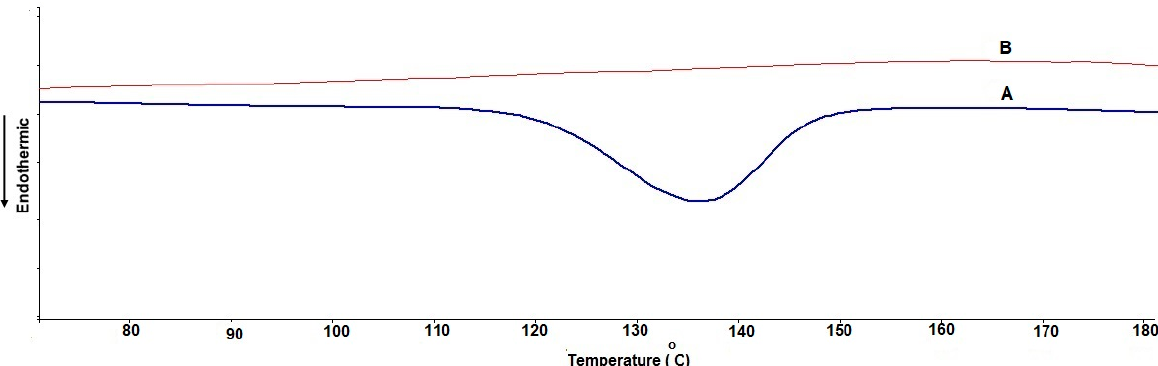
Figure 2. (A) Pure TCR drug used and (B) DSC thermograms of selected lyophilized TCR-loaded SPLs (F3 OA 1).